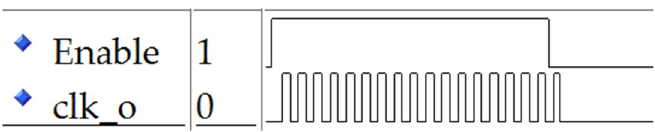
Figure 8. Timing simulation of the ring oscillator.